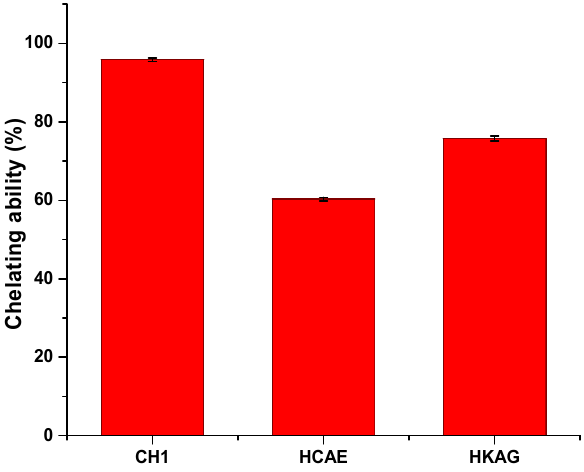
Figure 4. The chelating ability of protein hydrolysates: CH1, HCAE, and HKAG. The foam capacity is presented in Figure 5 and shows a high value for keratin hydrolysate (HKAG), followed by collagen hydrolysates, HCAE and CH1. The influence of pH value on foaming capacity was obvious and different for every protein hydrolysate.